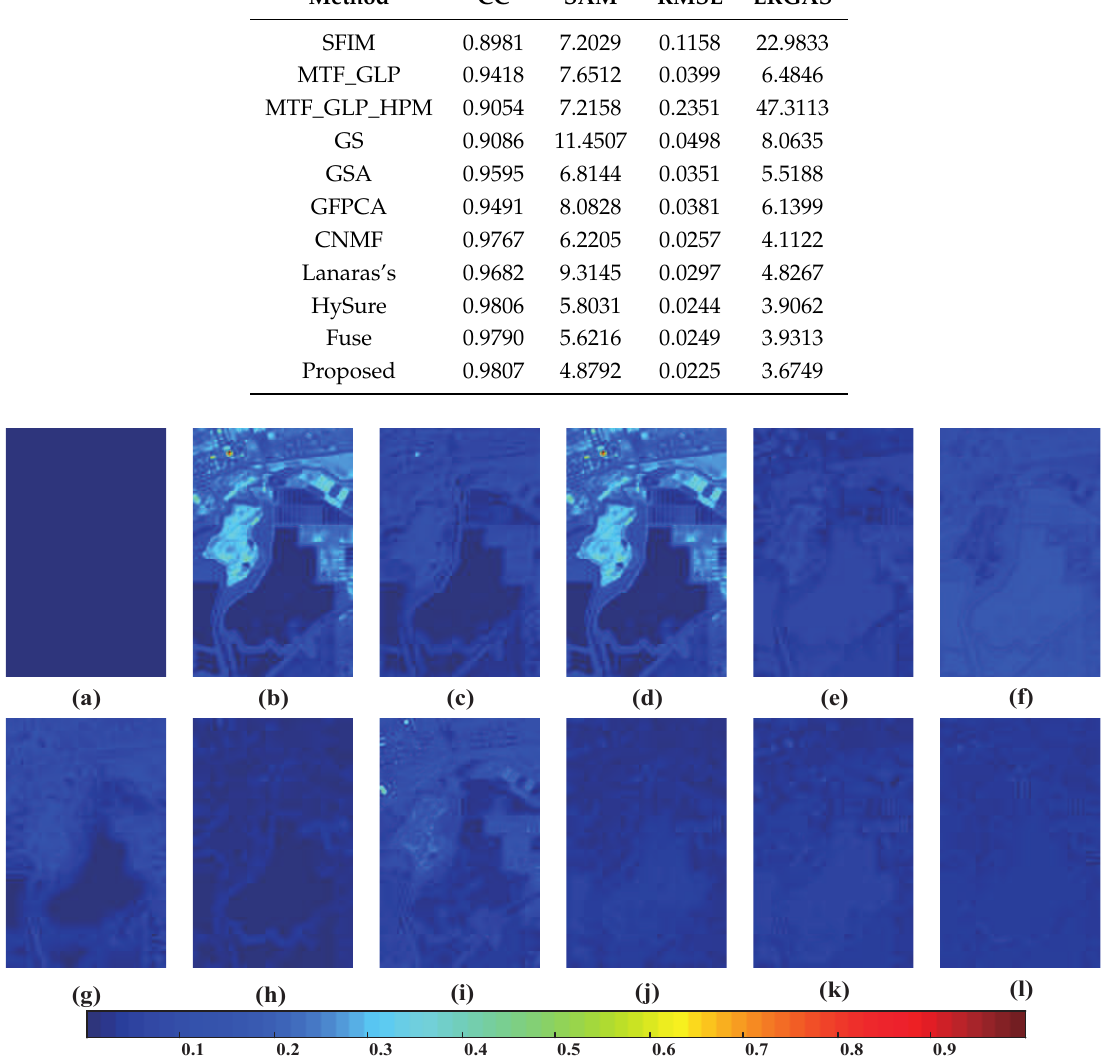
Figure 6. Absolute difference maps between the pansharpened results and the reference one obtained by different methods on the Moffett data set: ( a ) reference, ( b ) SFIM, ( c ) MTF-GLP, ( d )